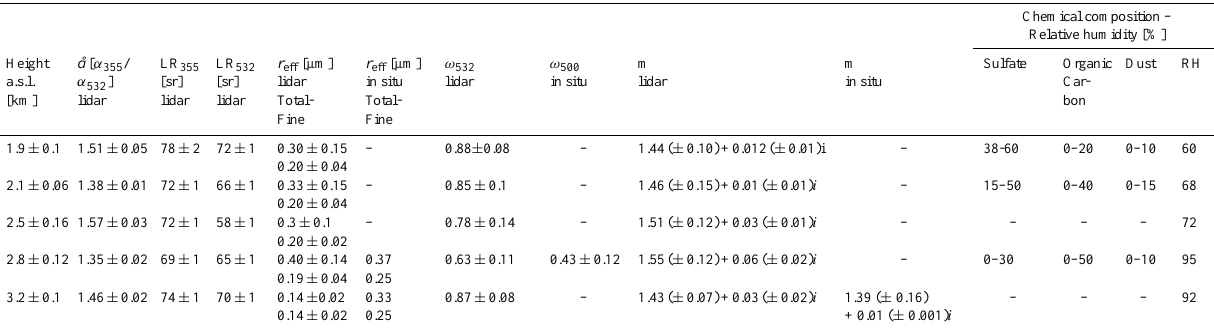
Table 1. Mean aerosol optical, microphysical and chemical properties derived from a synergy of Raman lidar and in situ aircraft data, as well as inversion and thermodynamic